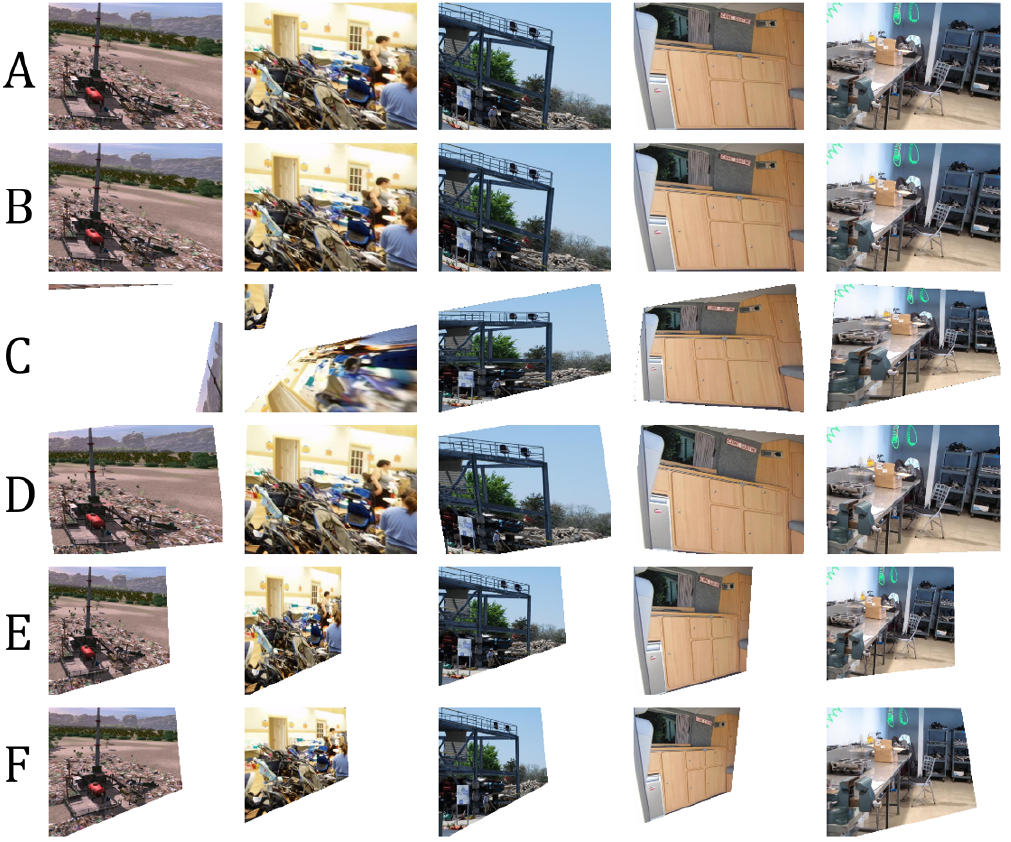
Figure 13. Results using unseen images from Places205 dataset [48]. ( A ): Distorted input images. ( B ): Corrected image using homography estimation ( C ): Corrected image using the technique of Chaudhury et al. [21]. ( D ): Corrected image using the technique of Li et al. [11]. ( E ): Corrected image using our method. ( F ):